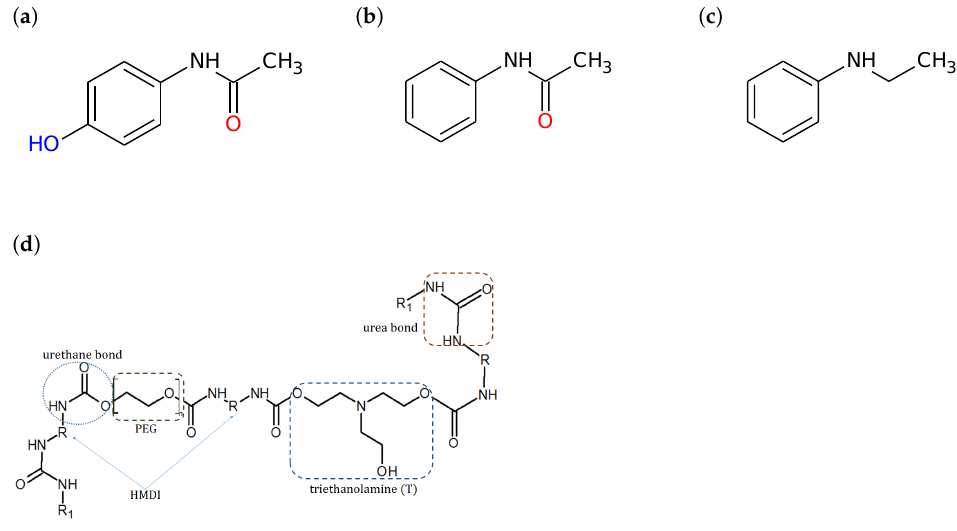
Figure 1. Chemical structure of ( a ) paracetamol (PAR), ( b ) acetanilide (ACT), ( c ) N -ethylaniline (NEA), and ( d ) fragment of the structure of the polyurethane hydrogel matrix